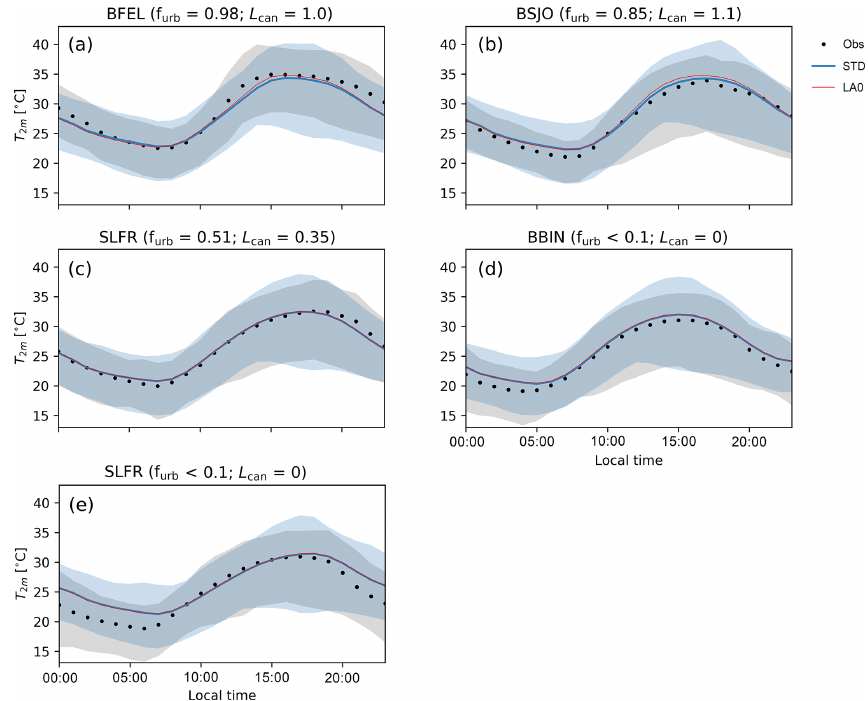
Figure 6. Comparison between period-averaged daily profiles of observed (Obs) and model-simulated 2m air temperature at the BFEL, BSJO, SLFR, BBIN and BLER sites during the study period. Black dots indicate the observations. Blue lines and red lines indicate the results from the STD and LA0 model runs, respectively. The range of variability within the selected period is shown as a shaded area for Obs (grey) and STD (light blue).